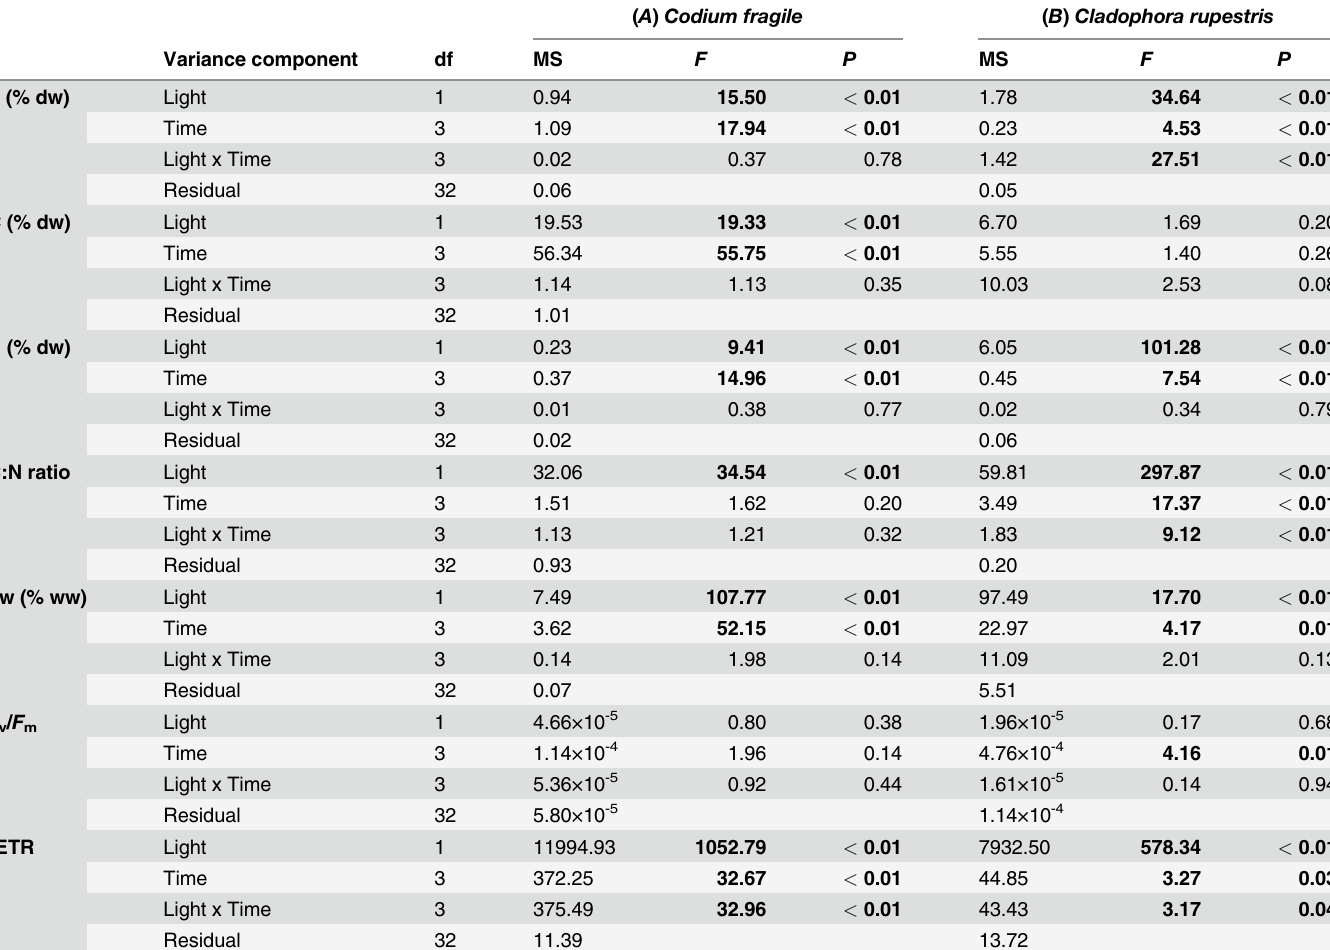
Table 2. Analysis of variance of different traits of Codium fragile ( A ) and Cladophora rupestris ( B ) kept under low and high light (Light) during the four-week experiment (Time). ( A ) Codium fragile ( B ) Cladophora rupestris Variance